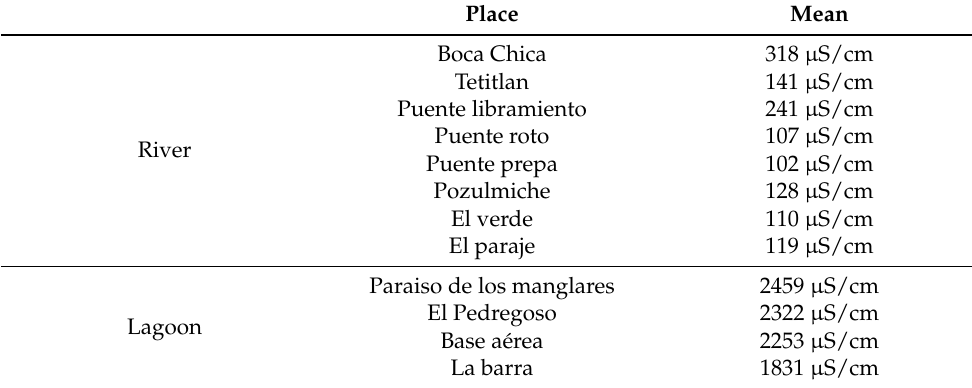
Table 6. Mean electrical